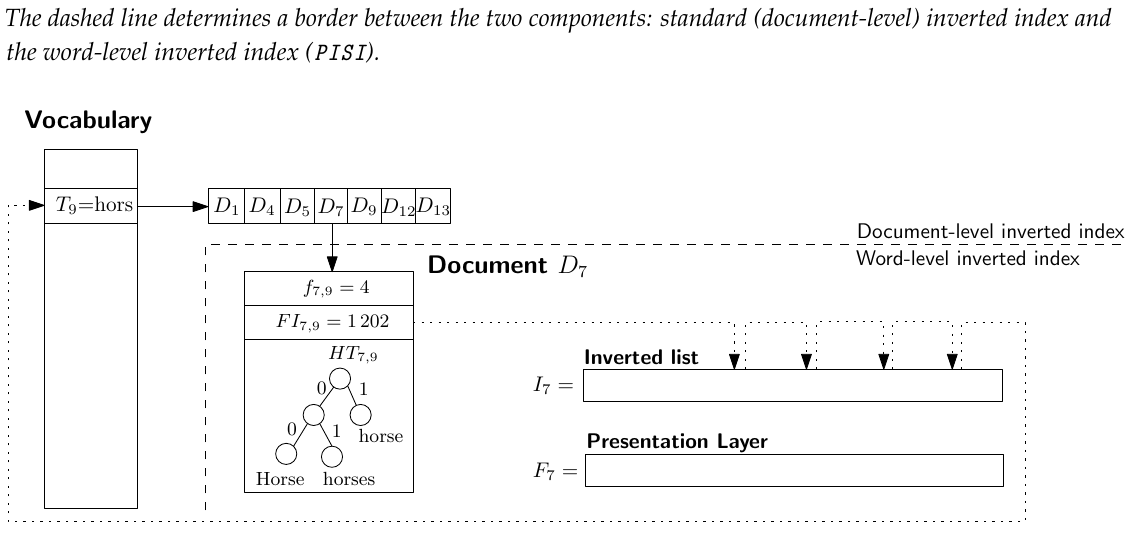
Figure 3. PISI data structure: the integration with the standard (document-level) inverted